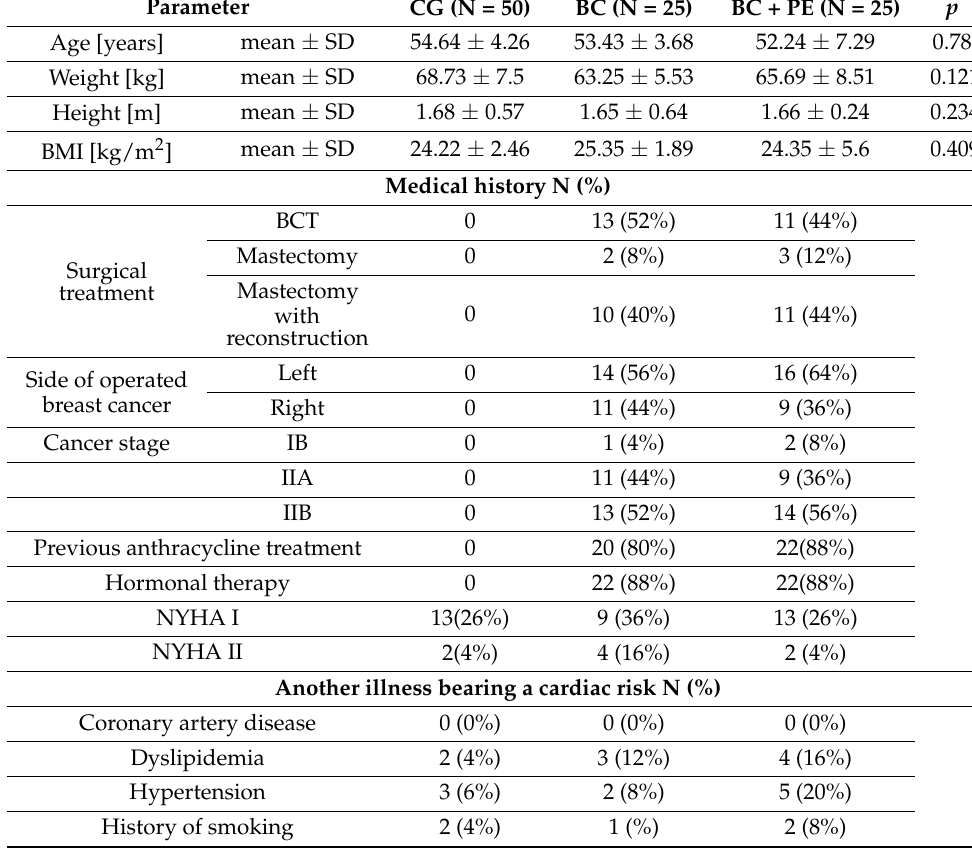
Table 1. Patients’